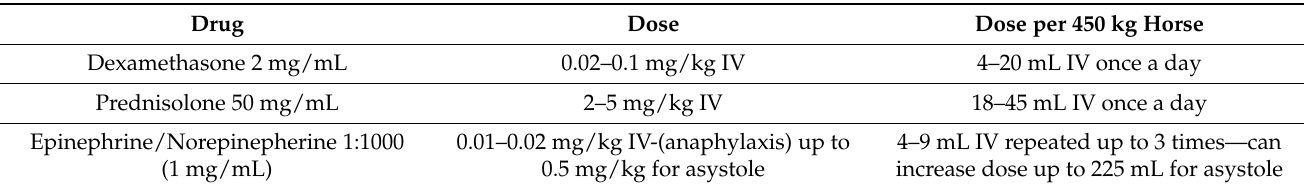
Table 4. Emergency Drug